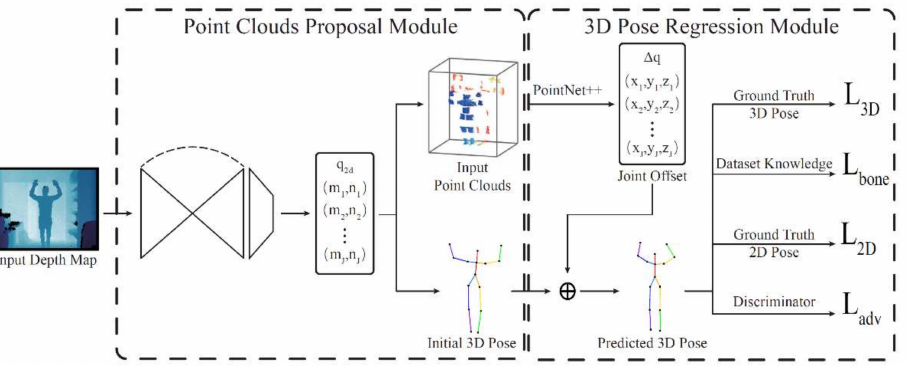
Figure 11. A schematic diagram of human joint estimation using Neural Network. The network consists of two modules, the point clouds proposal module and the 3D pose regression module. Using the input depth map, we first estimate the 2D human pose, and use it to sample and normalize the extracted point clouds from depth. Then we use the initial 3D pose converted from the estimated 2D pose and the normalized point clouds to predict the final 3D human pose. Figure from